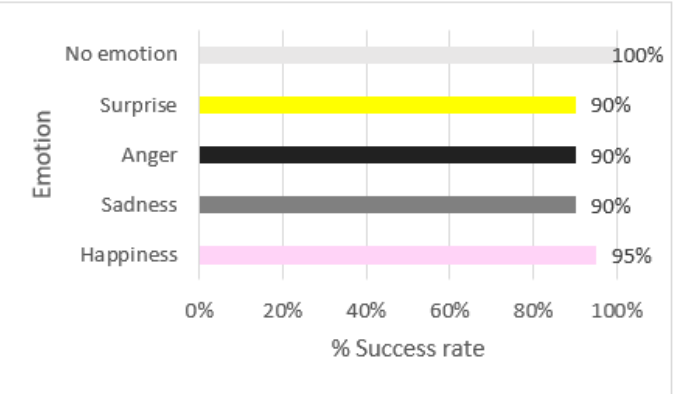
Figure 17. Simulation results of voice samples based on di ff erent emotions.